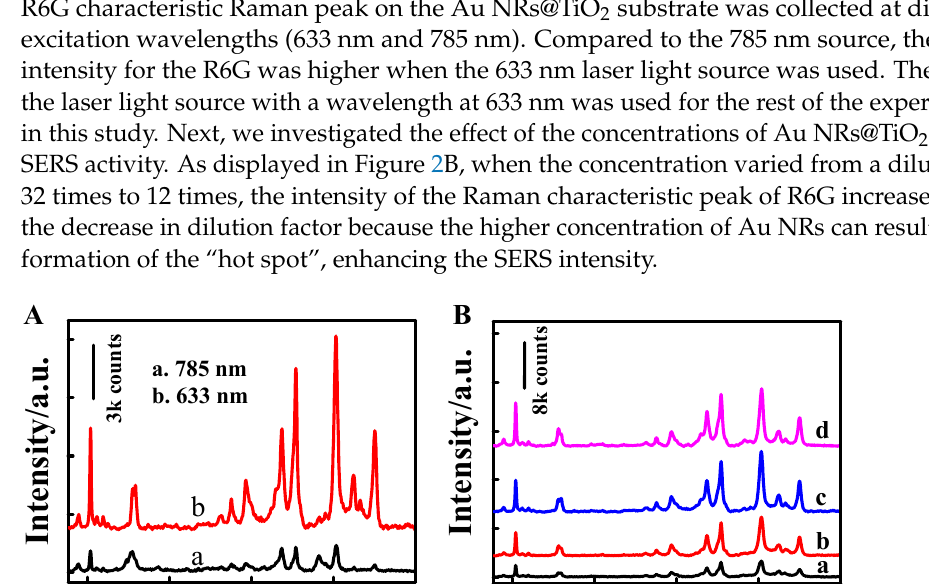
5 of 11 Figure 1. ( A ) UV − Vis spectra of Au NRs and Au NRs@TiO 2 nanostructures; ( B , C ) were TEM images of Au NRs and Au NRs@TiO 2 , respectively. ( D ) Scanning electronic microscopy (SEM) image of Au NRs@TiO 2.